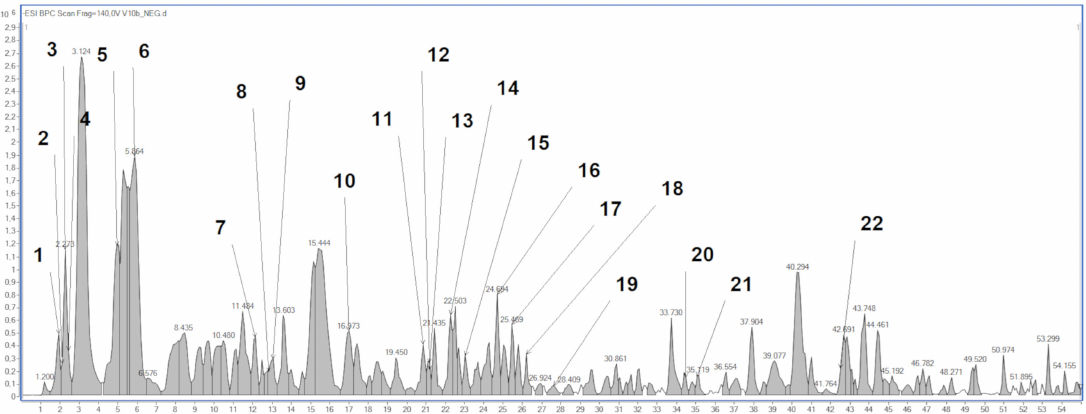
Figure 1. Base peak chromatogram of Crocus alatavicus (CA) extract by high-performance liquid chromatography-electrospray ionization-quadrupole-time of flight-mass spectrometry